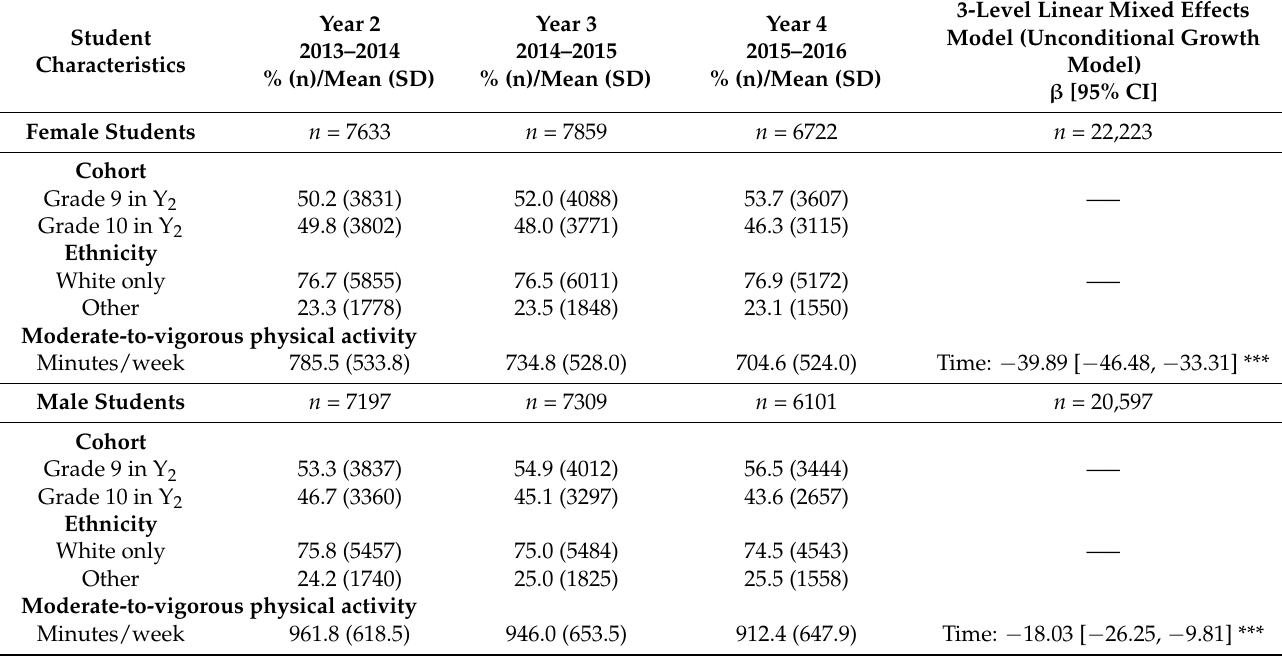
Table 2. Weekly minutes of moderate-to-vigorous physical activity, by gender, for students attending schools that partici- pated in Year 2 (2013–2014), Year 3 (2014–2015), and Year 4 (2015–2016) of the COMPASS Study in Ontario and Alberta,